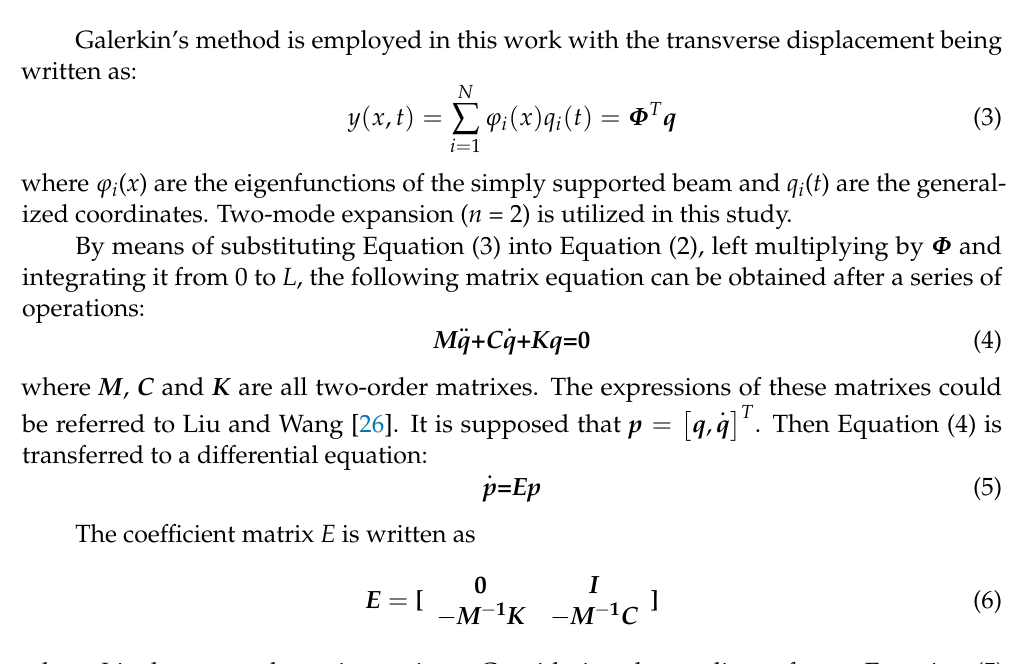
Figure 4. The liquid flow velocity at a fixed cross section located in the middle of the pipe over the time of the passage of several slug units.